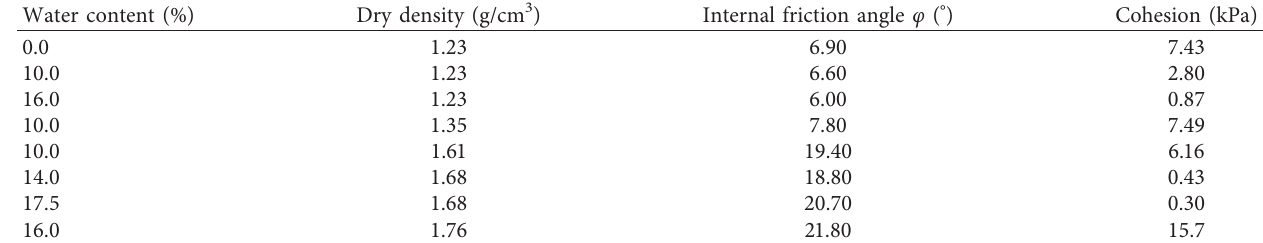
Table 4: Internal friction angles and cohesions corresponding to different conditions.